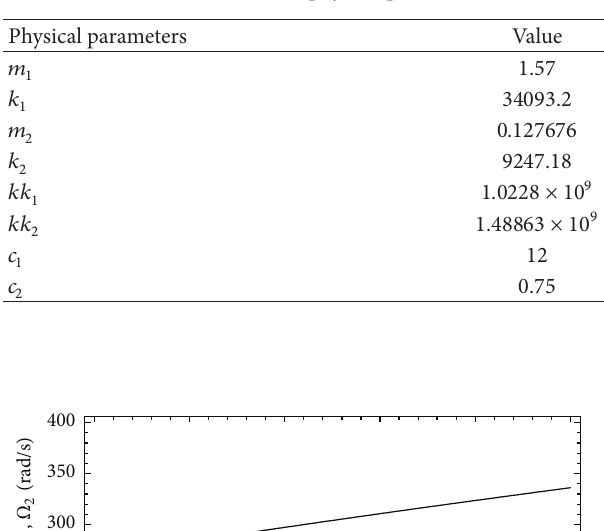
Table 1: The value of physical parameters.